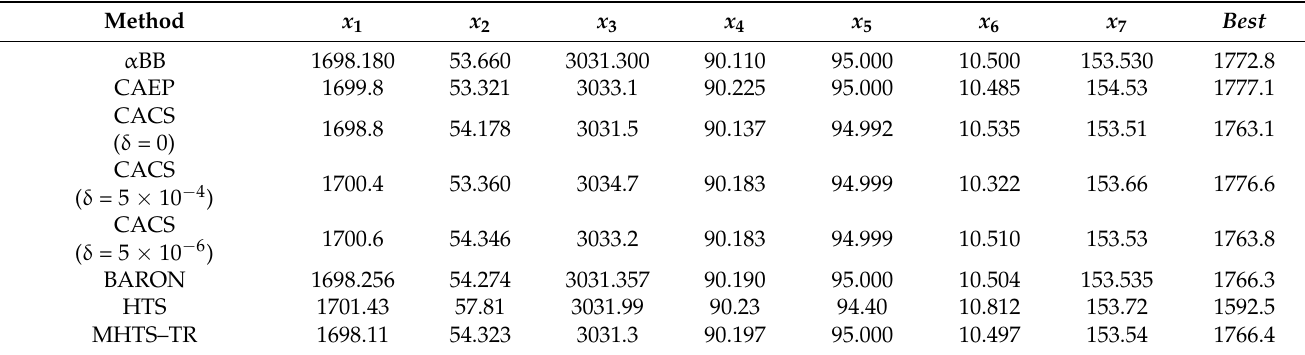
Table 7. The comparison results obtained by the α BB, CAEP, CACS, BARON, HTS, and MHTS–TR methods.